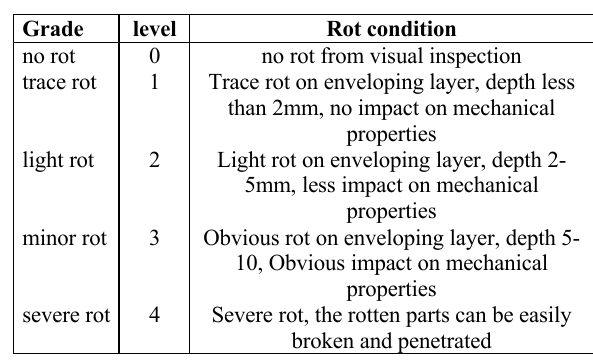
Figure 8 . Rot on the top of column